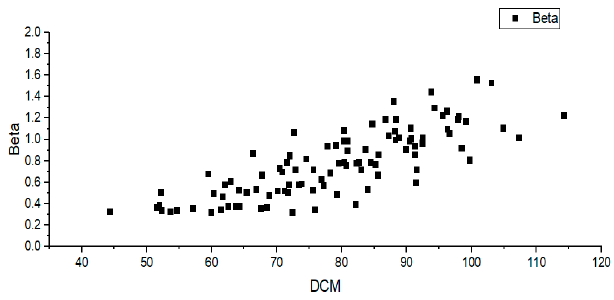
Figure 9. Distribution of DCM-optimal scattering coefficient.